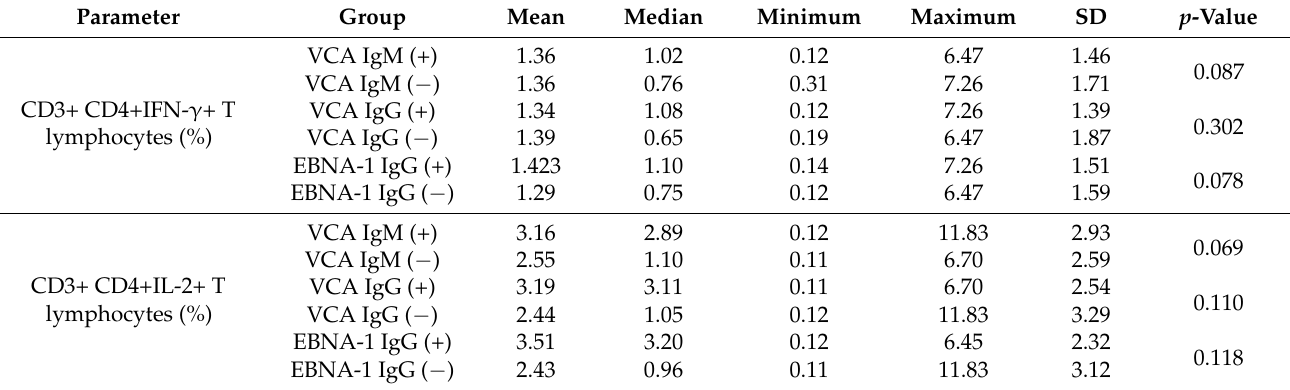
Table 7. Evaluation of the percentage of CD3+CD4+ T lymphocytes with intracellular expression of selected cytokines in patients with type 1 diabetes in relation to the presence of anti-VCA antibodies in the IgM, IgG and anti-EBNA-1 in the IgG